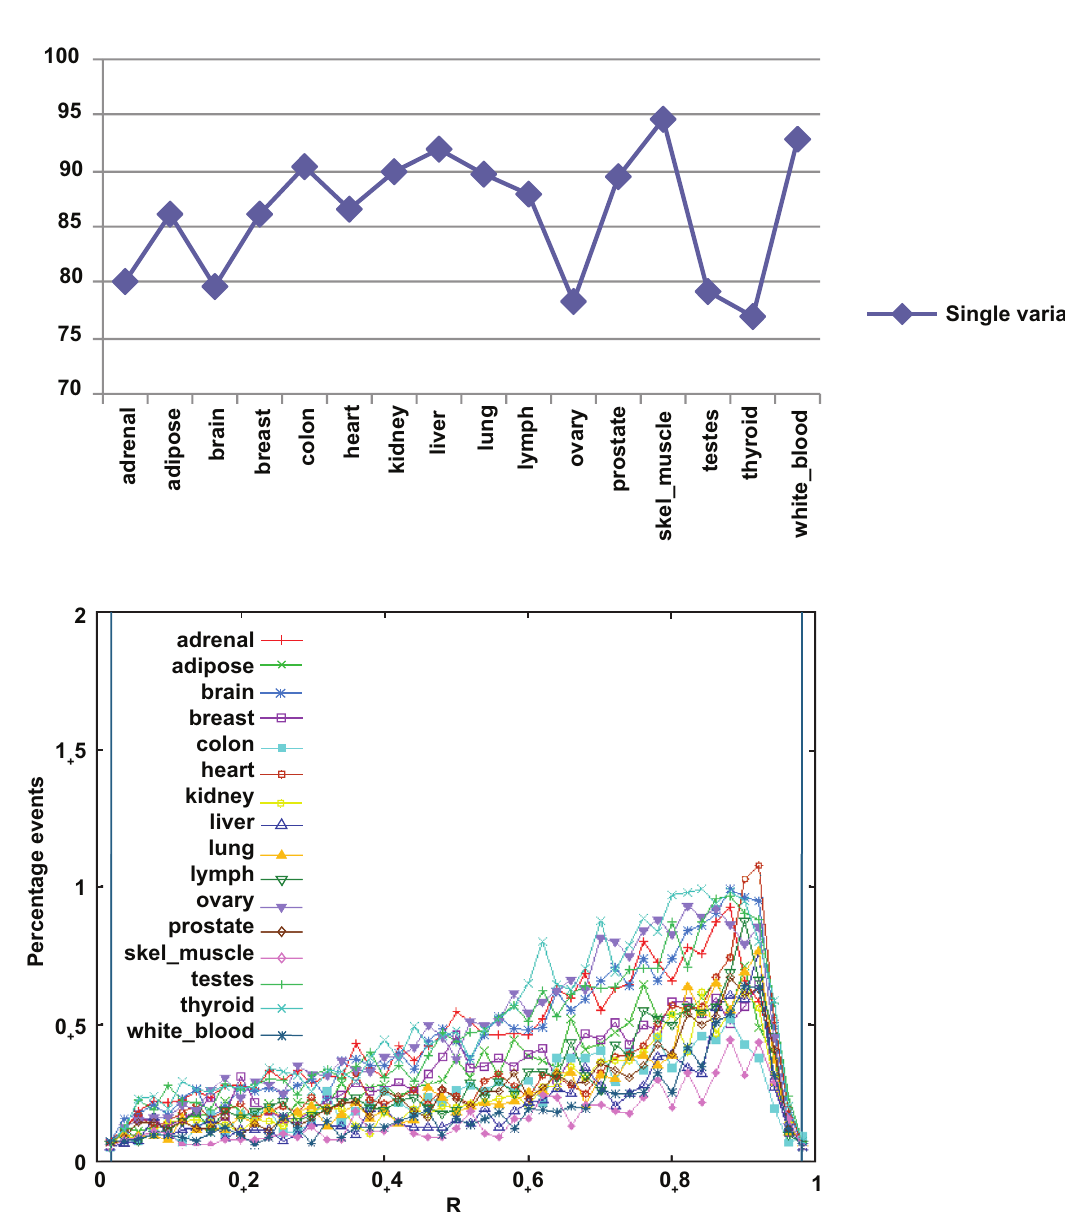
Figure 3. Splicing variation at skipped exon events as measured by the exon inclusion ratio R = FPKM sixteen tissues. Most events within a given tissue are single variant (top). When both isoforms are present in a tissue, the exon is typically contained in the major form (R ≥ 0.5)